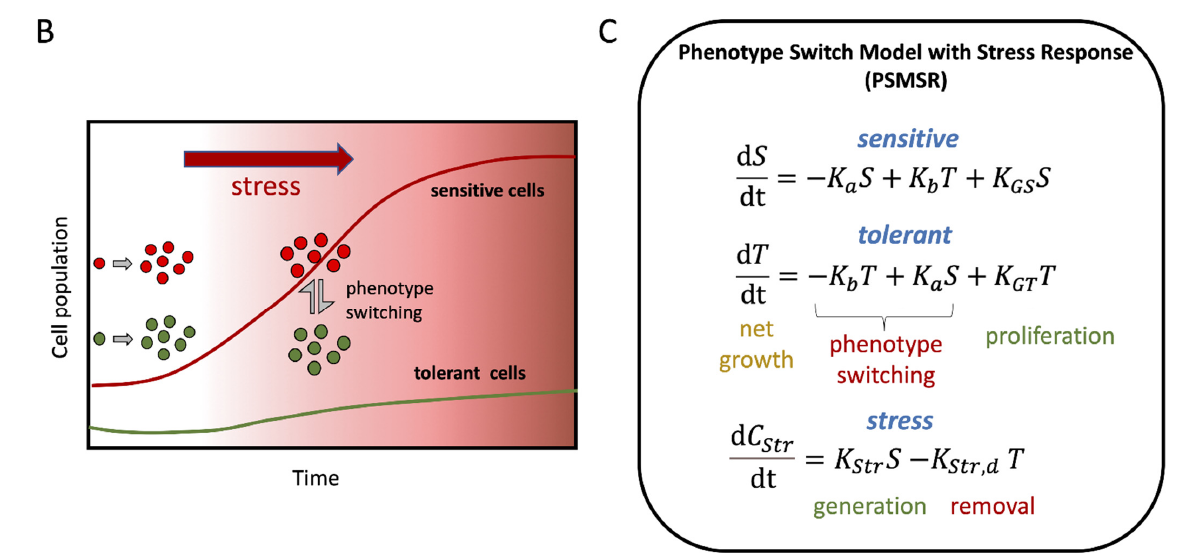
Figure 1. Schematic summarizing the experiment and the source of data used in developing the theoretical cell growth models. ( A ) The schematic representation of the different incubation duration, ratios, and treatments used for generating the data to develop the mathematical model. ( B ) schematic describing the principles on which the mathematical model PSMSR was developed; ( C ) panel representing the functional form of PSMSR (please see the main text for further details).